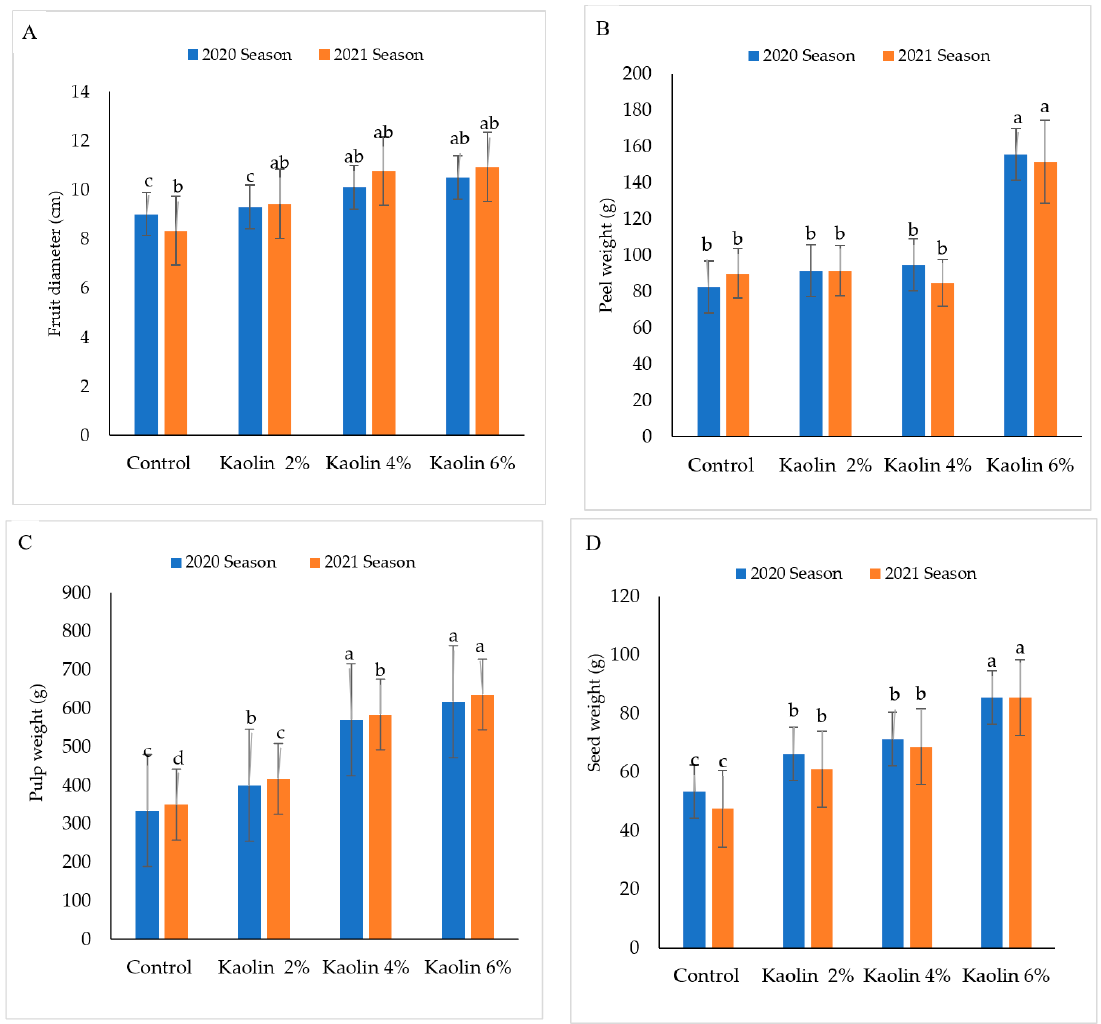
Figure 8. Effect of kaolin spray on: ( A ) fruit diameter (cm), ( B ) peel weight (cm), ( C ) pulp weight (g) and ( D ) seed weight (g) of Keitt mango cultivar during the seasons 2020 and 2021. Bars indicate mean values ± SE (n = 9). Different letters above columns indicate significant differences among pruning treatments at p = 0.05 according to Bartlett’s test.